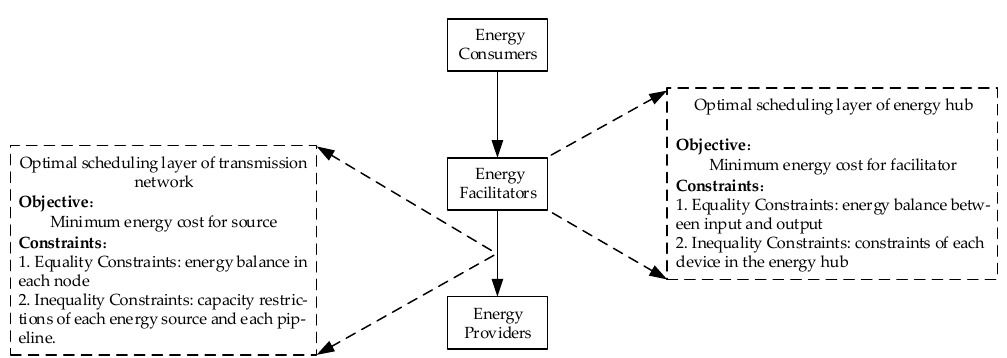
Figure 5. Hierarchical economic scheduling framework.